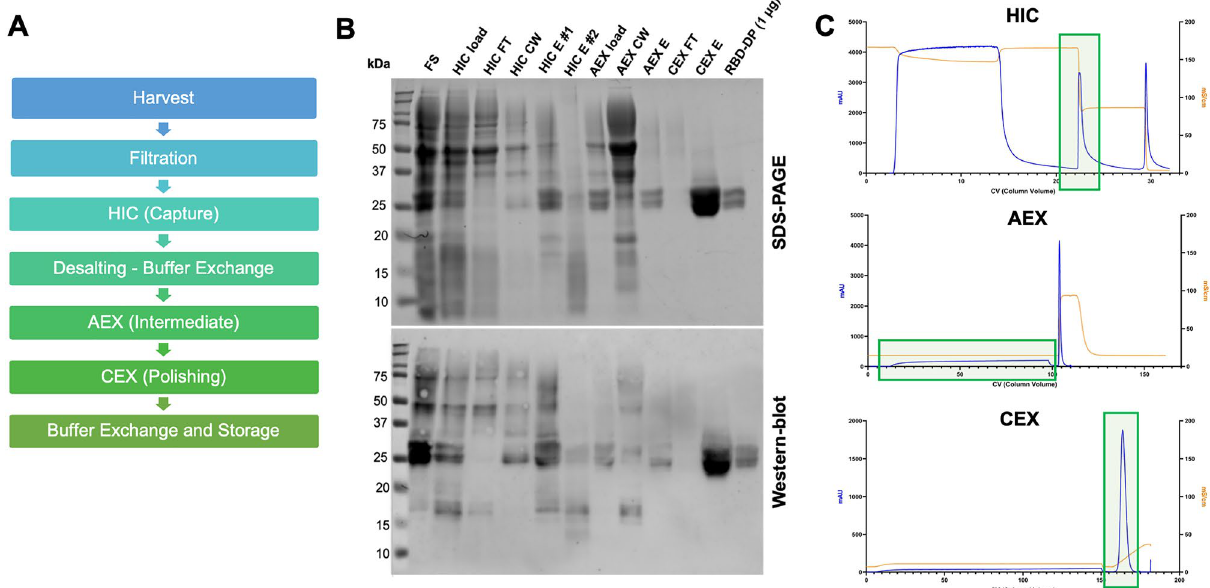
Figure 2. Purification of produced RBD-DP. ( A ) Purification flow-chart. ( B ) SDS-PAGE and Western blot analysis of the purification steps. FS fermentation supernatant, HIC hydrophobic interaction chromatography, AEX anion exchange chromatography, CEX cation exchange chromatography, FT flow-through, CW column wash, E elution. ( C ) Representative chromatograms of the purification process. Detection at 280 nm absorbance (mAU) and conductivity (mS/cm) were plotted. Fractions collected at each step are highlighted in light green